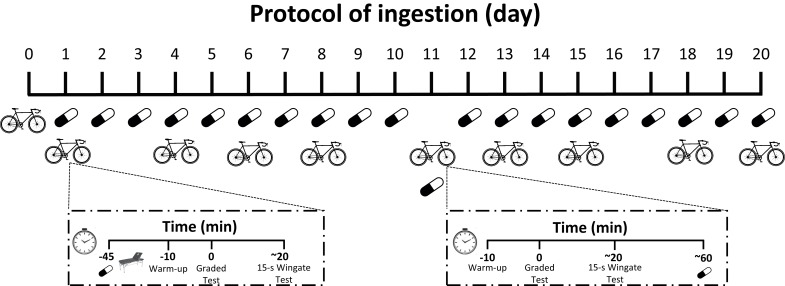
Experimental design of the investigation.Caffeine (3 mg/kg/day) or a placebo was administered for 20 consecutive days in a randomized order. Exercise performance was measured on day 0 (48 h before treatment) and on days 1, 4, 6, 8, 11, 13, 15, 18 and 20 with each protocol. Exercise performance assessment included a graded exercise test on a cycle ergometer to volitional fatigue and the 15-s Wingate test 45 min after the ingestion of the assigned capsule. Only on day 11 during each treatment, participants ingested the capsule after the end of the exercise.